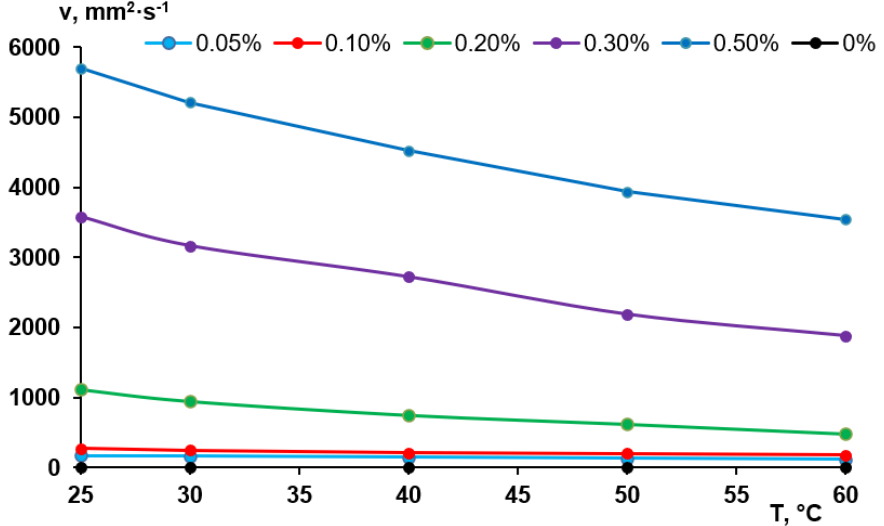
Figure 3. Viscosity of the aqueous solutions of Praestol 859 at different concentrations vs. temperature.